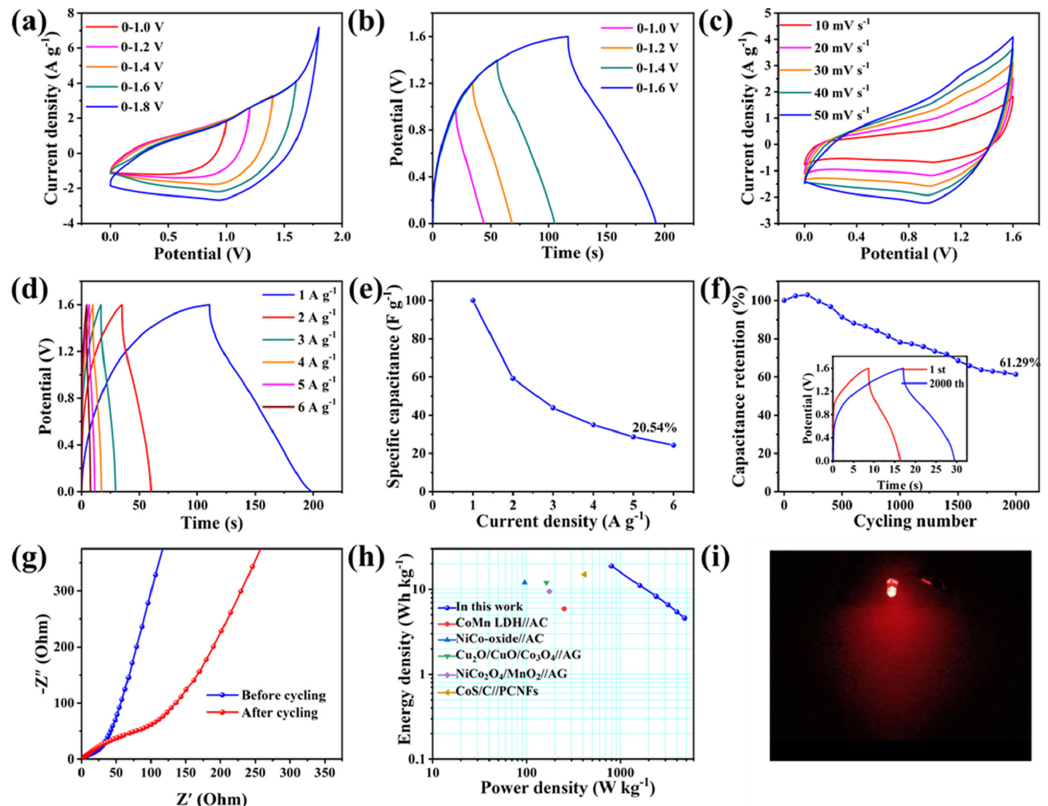
Figure 7. The performance evaluation of ASC device. ( a ) CV curves at 30 mV s − 1 with different potential windows, ( b ) GCD curves at 3 A g − 1 with different current densities, ( c ) CV curves at different scan rates, ( d ) GCD curves at different current densities, ( e ) rate capacities, ( f ) cycling stability and the GCD curves before and after cycling (inset), ( g ) Nyquist plots before and after cycling, ( h ) the Ragone plot of energy and power densities, and ( i ) the LED indicator lit up by two ASC devices.